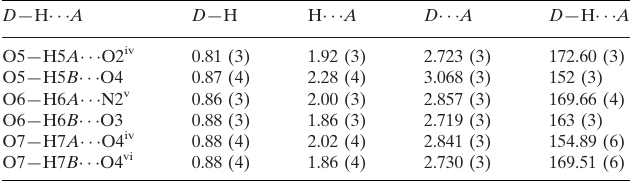
Hydrogen-bond geometry (A˚ , (cid:3)